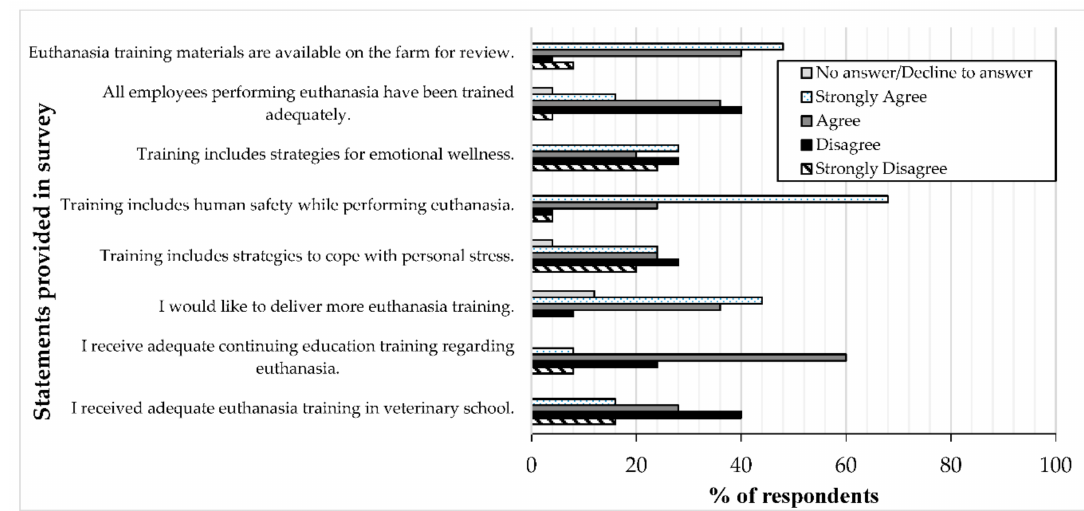
Figure 3. Respondents ( n = 25) were asked to indicate their level of agreement with various statements related to euthanasia training. The options available to choose from were: Decline to answer, Strongly agree, Agree, Disagree, and Strongly Disagree. Some respondents did not answer the